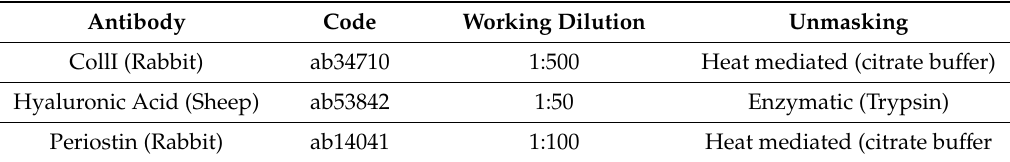
Table 1. List of the primary antibodies used for